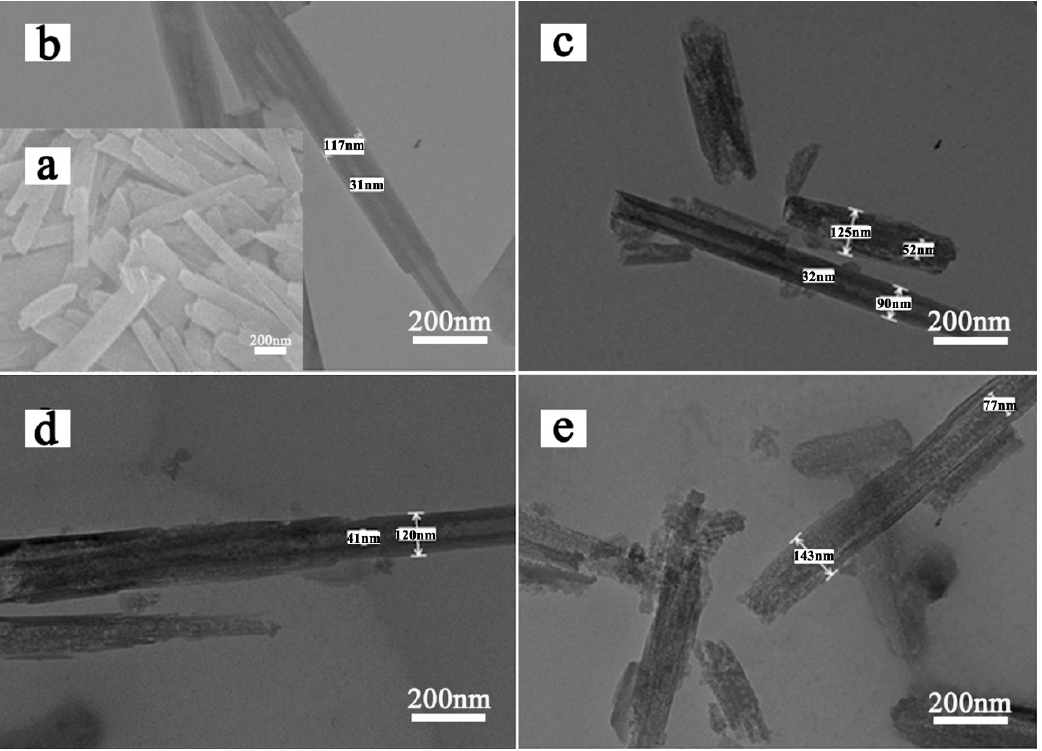
Figure 2. SEM ( a ) images of HNTs-0; TEM images of ( b ) HNTs-0, ( c ) HNTs-70, ( d ) HNTs-80 and ( e ) HNTs-90.